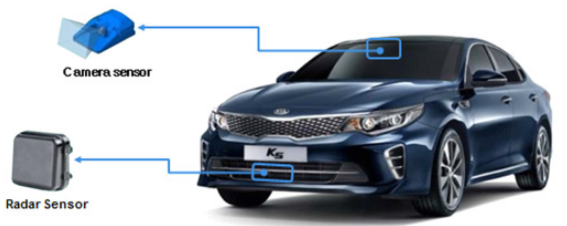
Figure 2. AEBS (Autonomous Emergency Braking System) Sensor Devices.